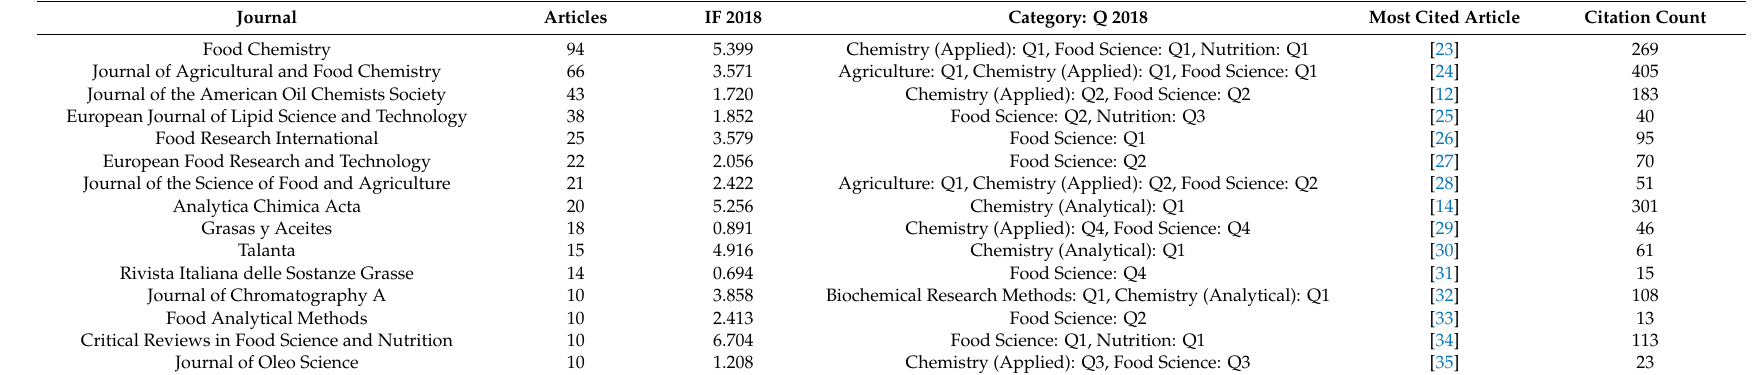
Table 2. Journals having published at least 10 articles between 1991 and 2018, sorted by their respective number of articles, with their associated impact factor (IF), subject category(ies), ranking in each category notified by their quartile (Q), most cited article and citation count up to